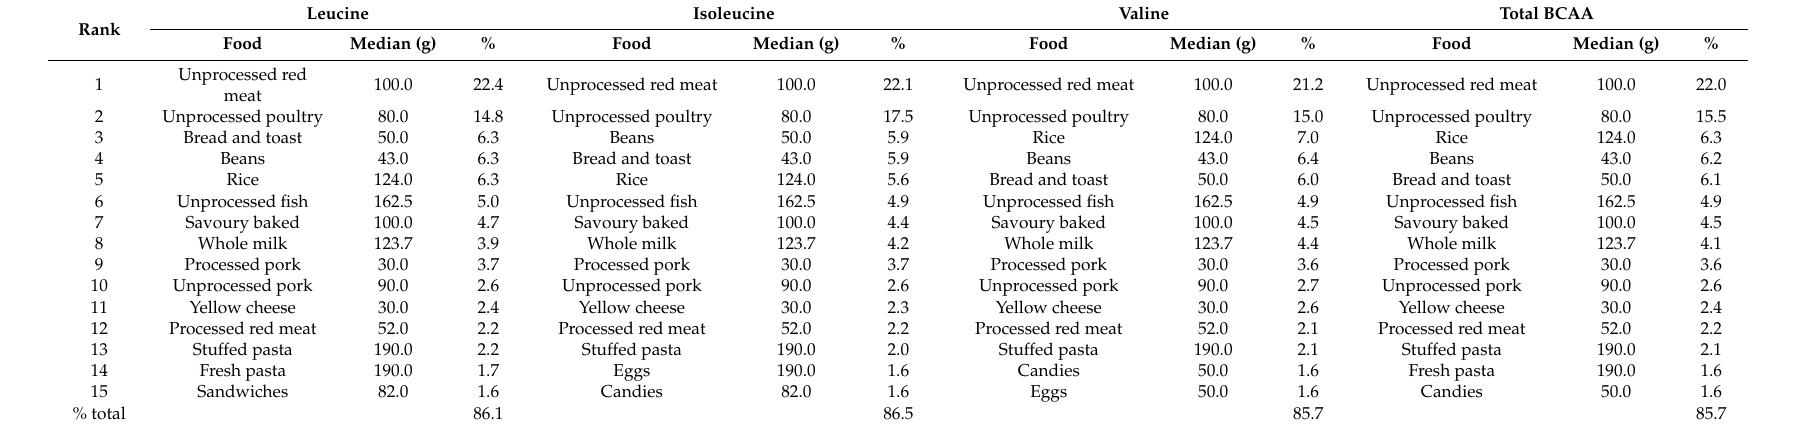
Table 5. Main food contributors to dietary intake of branched chain amino acids in adults, ISA Capital, S ã o Paulo, Brazil,